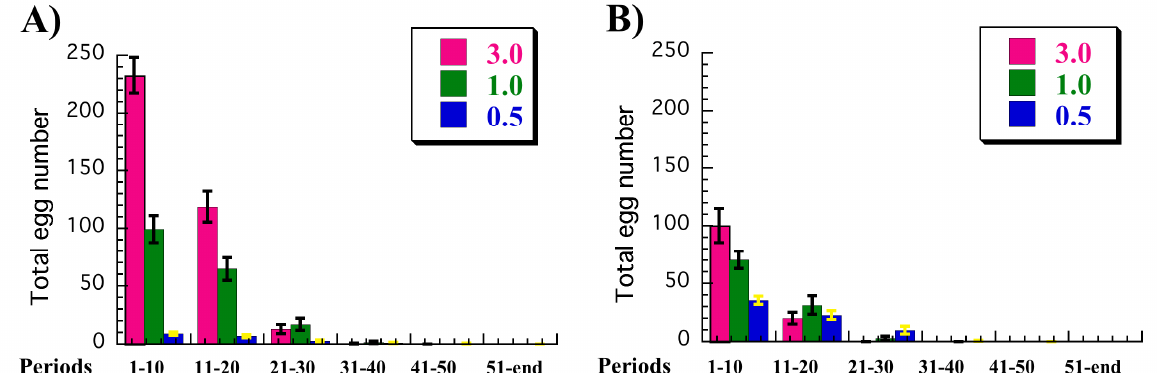
FIGURE 2. Overexpression of SP increases female response to different caloric food levels. Average total number of eggs laid by G-10 flies overexpressing SP (A) and genetic controls, cn, ry (B) kept on 3.0 X (magenta), 1.0X (green), or 0.5X (blue) food levels during 10-day periods. Periods are expressed in days. There is a bigger difference in the total number of eggs per period laid by G-10 compared to control females on 1.0X and 3.0X food. However, G-10 females laid fewer eggs on 0.5X food compared to cn, ry females. There were 20 females in each